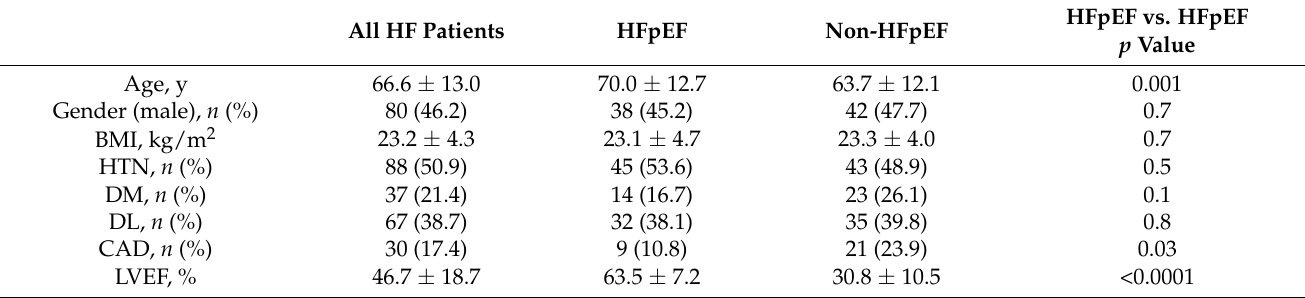
Table 1. Patient characteristics at baseline in all HF patients and HFpEF and non-HFpEF groups. All HF